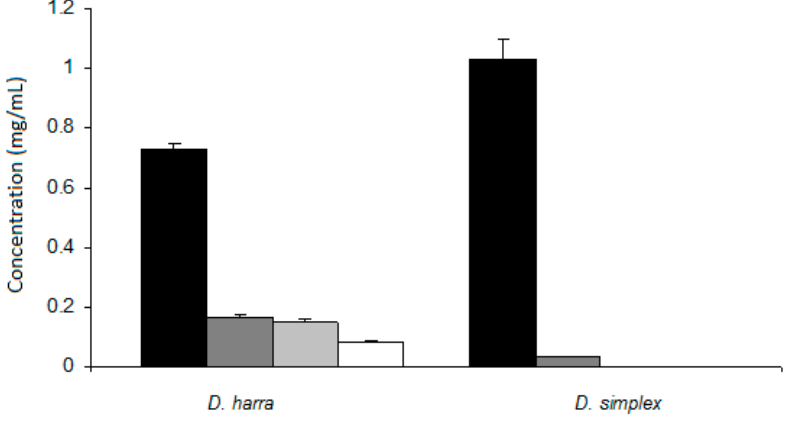
Figure 1. Concentration of flavonols and flavones before and after contact with artificial saliva , gastric and intestinal fluid .